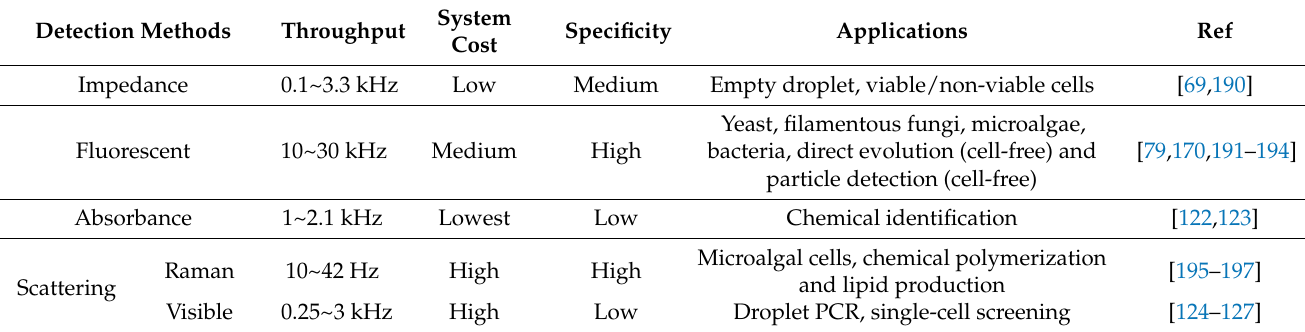
Table 1. Summary of all reviewed detection methods and their critical performance factors.